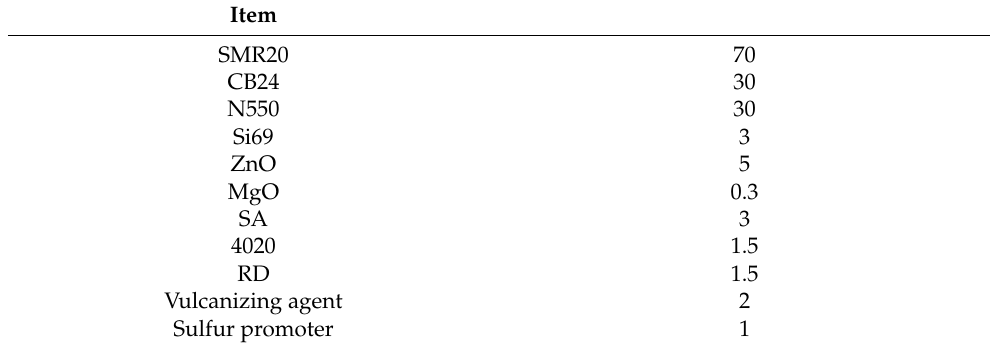
Table 1. Experiment formula.